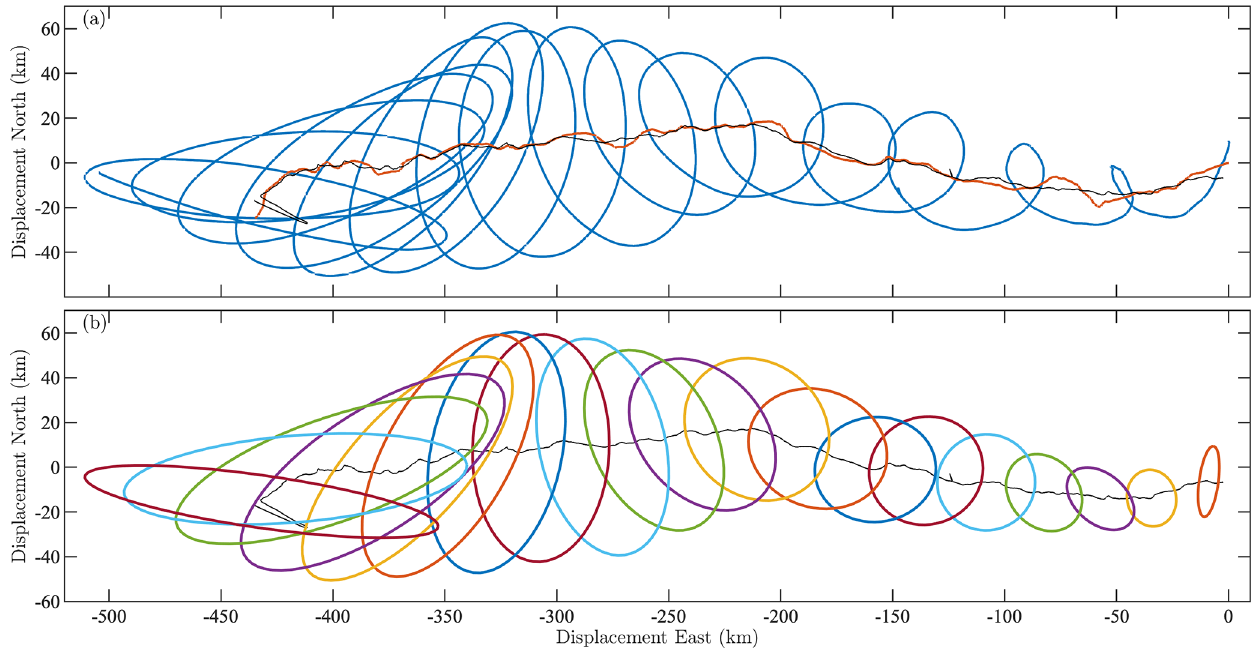
Figure 5. Panel (a) shows the signal from Fig. 4a, modified through the addition of a uniform westward drift together with a stochastic component. The sum of the westward drift and the stochastic component is the red curve, which defines the moving center for the modulated elliptical signal. Panel (b) presents ellipses inferred using the wavelet ridge method. The thin black line in both panels is the estimated background displacement curve (cid:98) x (cid:15) (t) from the wavelet ridge analysis, an estimate of the red curve in (a) .